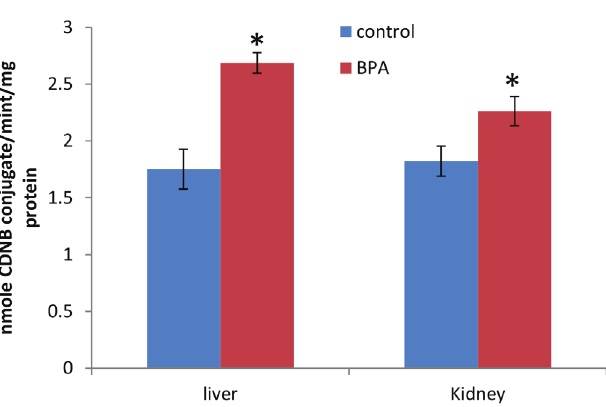
FIGURE 5 - Glutathione-S-transferase activity in the liver and kidneys of C.idella (n=5), exposed to the sublethal concentration of BPA for 14 days. The values given are mean ± S.E.M. * = p<0.05.